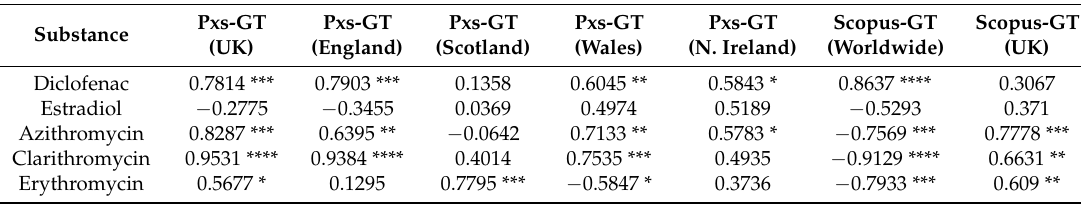
Table 7. Correlations amongst Prescriptions, Google Hits and Published Scientific Papers for Diclofenac, Estradiol, Azithromycin, Clarithromycin, and Erythromycin. Pxs-GT Pxs-GT Pxs-GT Pxs-GT Pxs-GT Scopus-GT Scopus-GT Substance (UK) (England) (Scotland) (Wales) (N. Ireland) (Worldwide) (UK) Diclofenac 0.7814 *** 0.7903 *** 0.1358 0.6045 ** 0.5843 * 0.8637 **** 0.3067 Estradiol − 0.2775 − 0.3455 0.0369 0.4974 − 0.5293 Azithromycin 0.8287 *** Clarithromycin 0.9531 **** 0.9384 **** − 0.9129 **** 0.6631 ** Erythromycin 0.5677 * 0.1295 0.7795 *** − 0.5847 * 0.3736 − 0.7933 *** 0.609